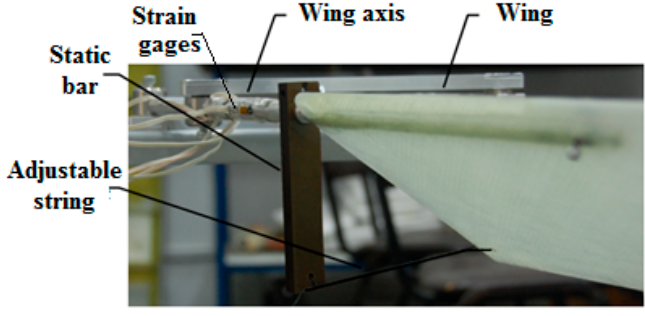
Figure 13. The angle adjuster.